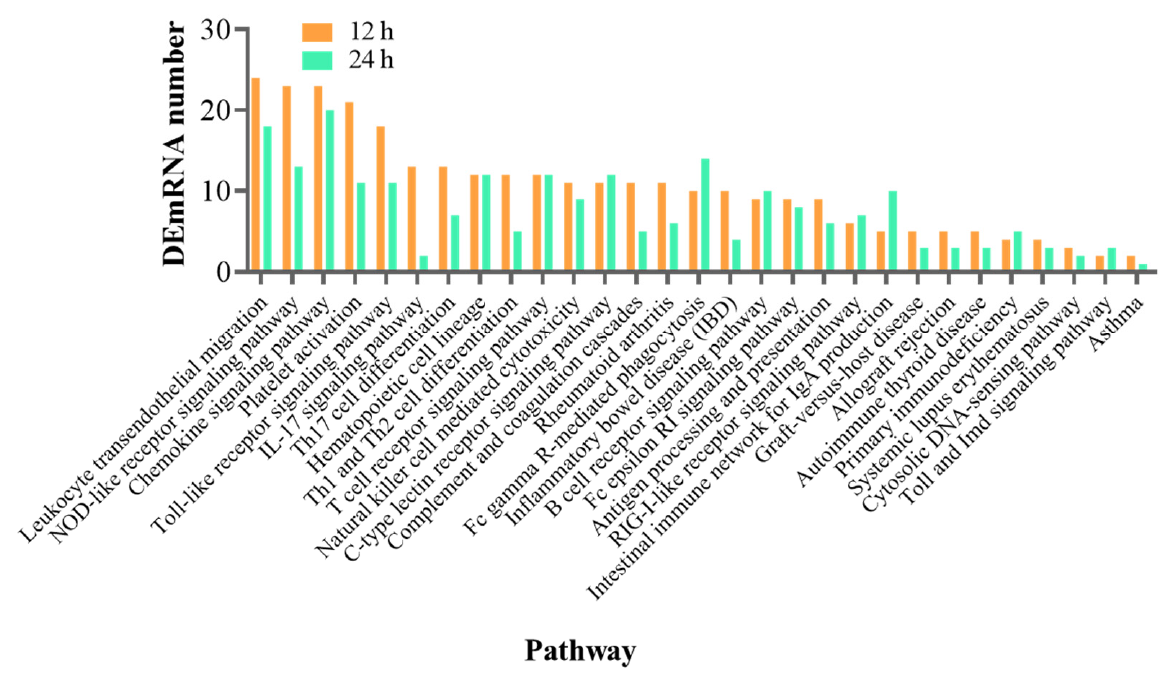
Figure 4. Immune-related KEGG pathways enriched in the DEmRNAs. The x and y axes show the KEGG pathways and the number of associated DEmRNAs, respectively.